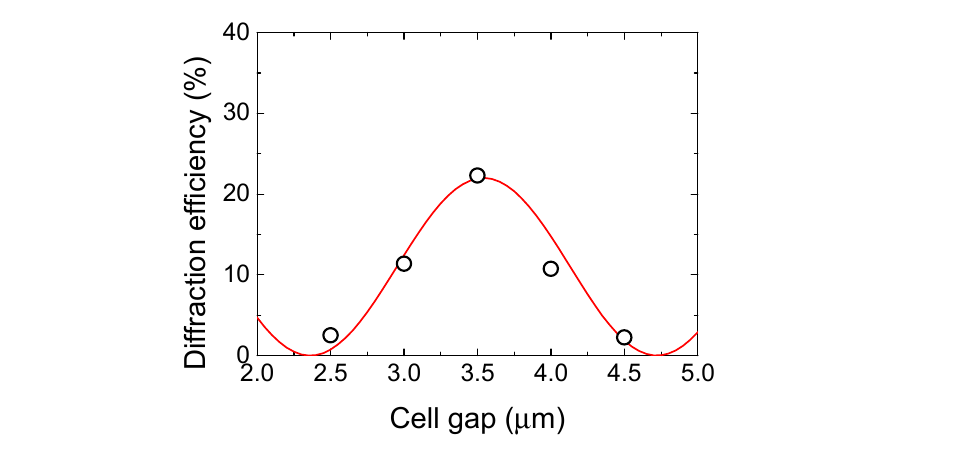
Figure 5. Diffraction efficiency (dots and line represent measured and fitted results with the proportional expression, respectively) at first-order of the ULH cells by changing the cell gap with a fixed pitch length of 1.25 μ m.